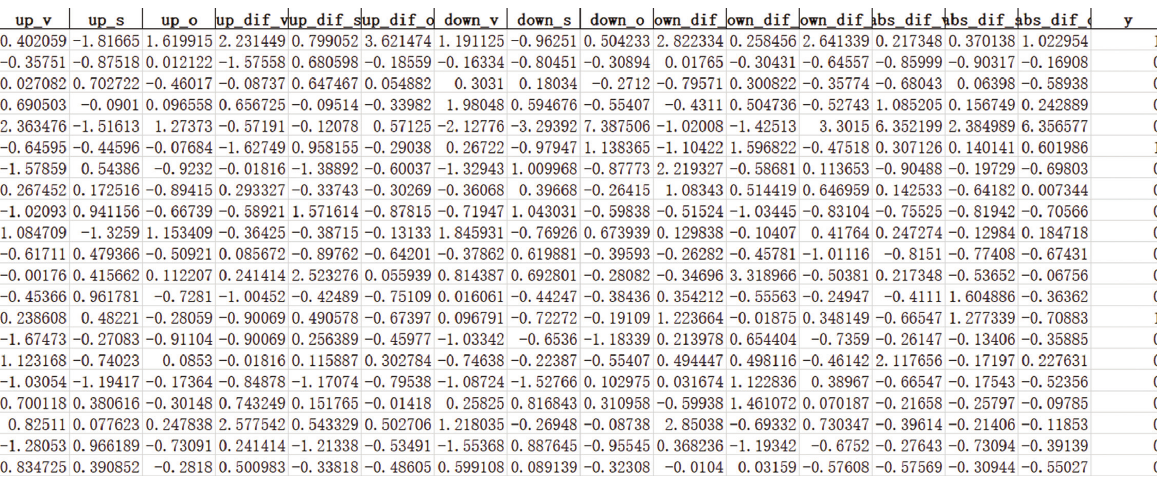
Figure 4: Small sample data